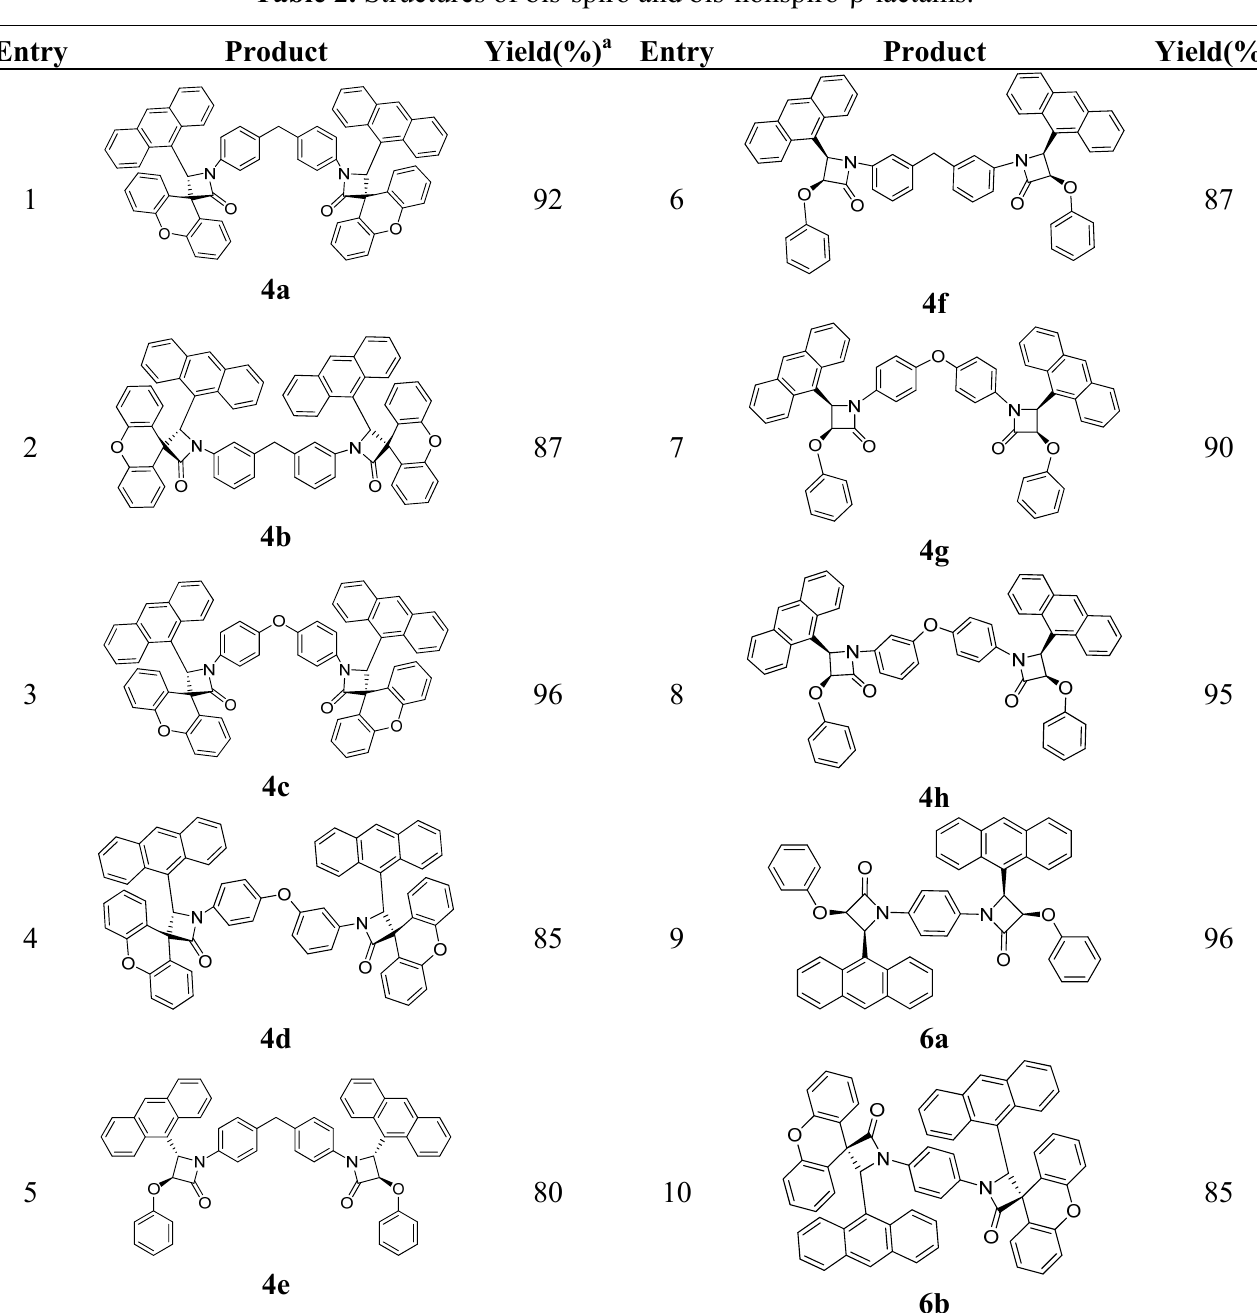
Table 2. Structures of bis-spiro and bis-nonspiro- β